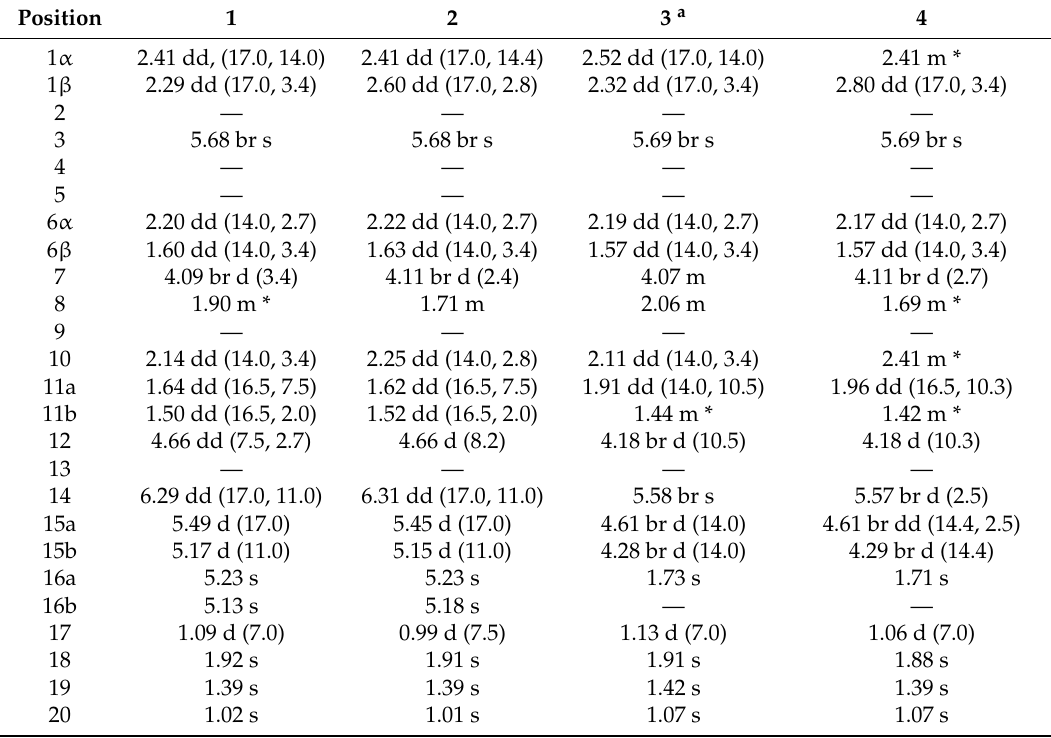
a Data are given for comparison with the new compound 4. * Overlapping signals.